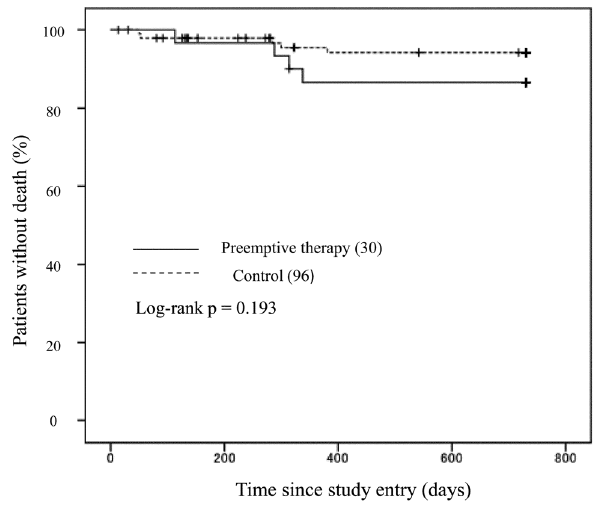
Figure 3. Kaplan-Meier curve showing the time to death in the preemptive and non-preemptive therapy groups. There was no significant difference in the survival rate between the two groups (p=0.193, Log-rank